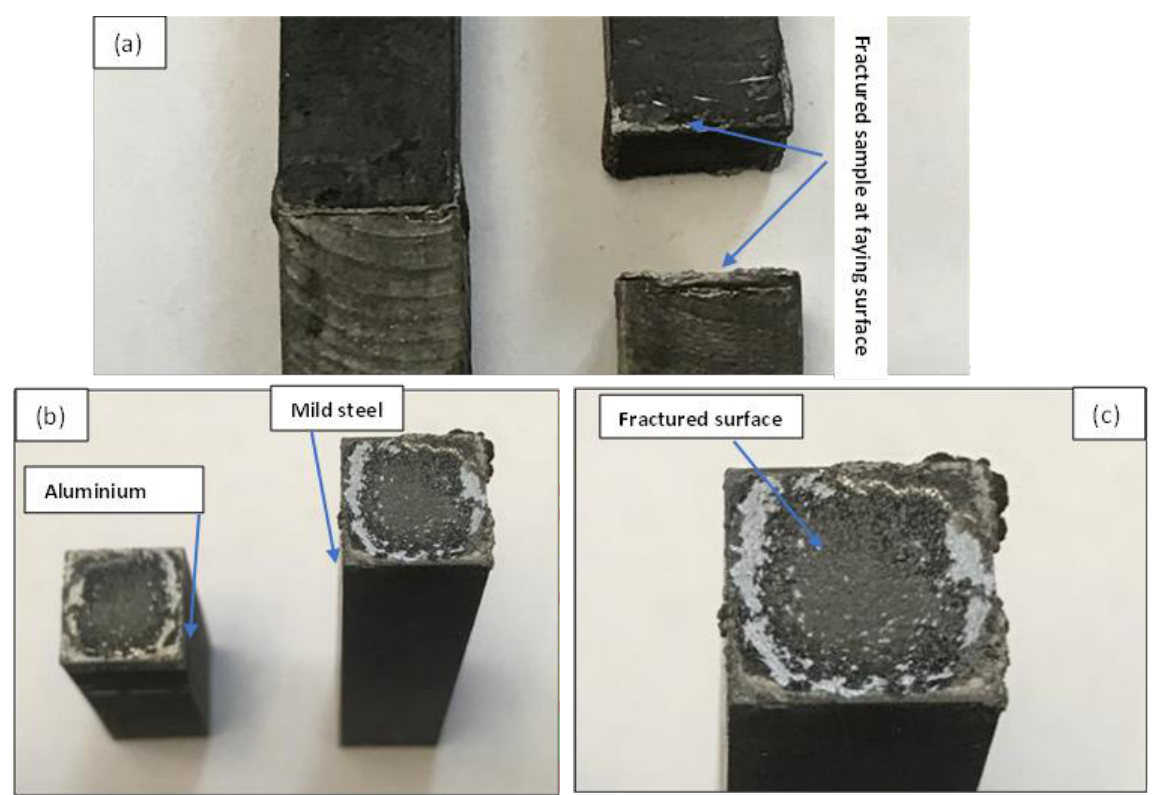
Figure 14. Fractured sample from the impact test: ( a ) Fractured sample at faying surface; ( b ) fractured surface of aluminium and mild steel; ( c ) close-up of the fracture surface of mild steel.